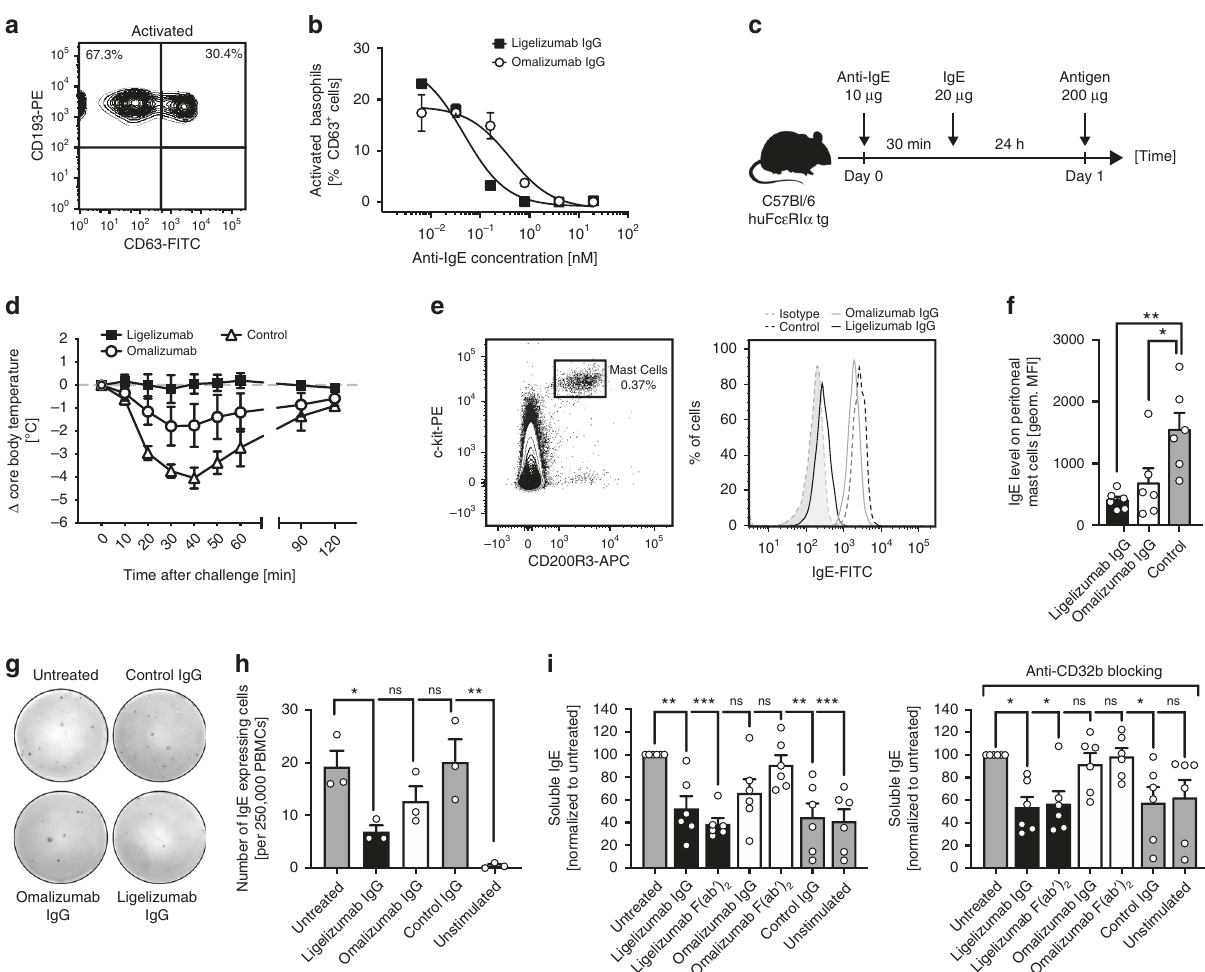
Fig. 5 Inhibition of basophil activation and IgE production of B-cells by ligelizumab or omalizumab. a NIP 7 -BSA-mediated activation of isolated CD193 + primary human basophils resensitized with JW8-IgE using CD63 as degranulation marker by fl ow cytometry. b Dose-dependent inhibition of primary human basophil activation by pre-incubation of JW8-IgE with increasing concentrations of ligelizumab or omalizumab IgG and subsequent stimulation of the cells with 100 ng/ml NIP 7 -BSA. Activation curves for technical duplicates were fi tted using a non-linear regression. c Experimental setup for the passive systemic anaphylaxis assay with huFc ε RI α tg mice. d Changes in body core temperature after antigen challenge for mice treated with ligelizumab, omalizumab or PBS as control ( n = 6 per group; pooled data from two individual experiments). Representative fl ow plots ( e ) and absolute quanti fi cation ( f ) of fl ow cytometric analysis of peritoneal mast cells after passive systemic anaphylaxis. g Representative pictures of IgE ELISpots with PBMCs from human donors ( n = 3 donors) that were stimulated with human recombinant IL-4 and anti-human CD40 antibody in the presence of a control IgG antibody, ligelizumab or omalizumab IgG. h Quanti fi cation of the number of IgE expressing cells. i Quanti fi cation of soluble IgE in cell culture supernatants of PBMCs from human subjects ( n = 6 donors) that were stimulated with human recombinant IL-4 and anti-human CD40 antibody in the presence of ligelizumab IgG or F(ab ′ ) 2 fragments, omalizumab IgG or F(ab ′ ) 2 fragments or a control IgG antibody. Data are shown as mean ± SEM. Different treatments were compared relative to the untreated group using one-way ANOVA with Dunnett ’ s multiple comparison referenced to untreated controls. * P < 0.05, *** P < 0.001. Source data are provided as Source Data fi